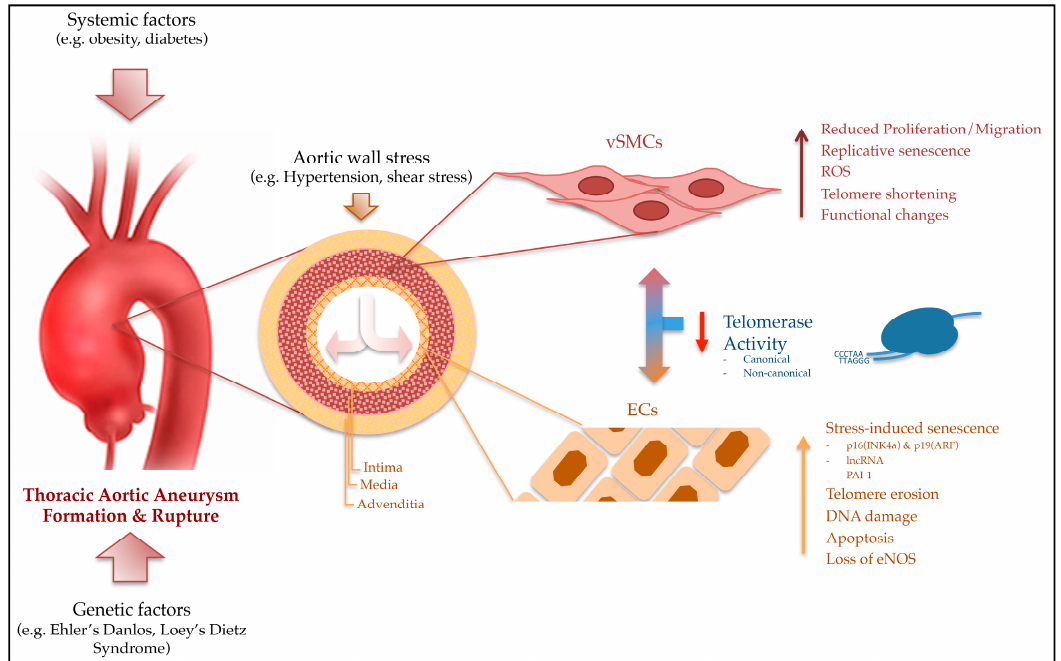
Figure 1. Multiple factors are associated with thoracic aortic aneurysm formation. The influence of telomerase activity on vascular smooth muscle cells (vSMC) and endothelial cells (EC) and the regulatory interaction between both cells is of particular importance.